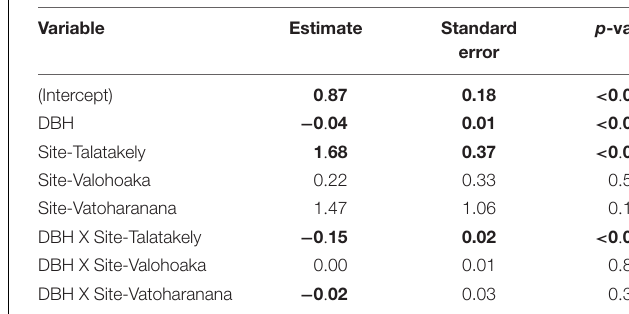
TABLE 1 | Parameter estimates of general linear model for Calophyllum paniculatum survival including interaction term between sampling sites and